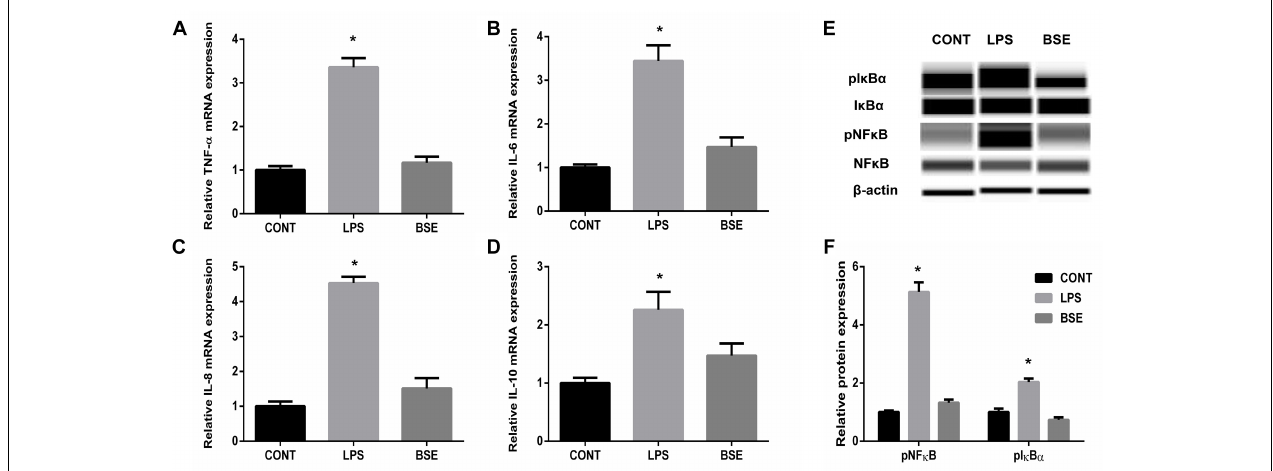
FIGURE 2 | Effects of Blidingia sp. extract on expression of inflammatory cytokines and expression of proteins involved in NF κ B pathway in ileum of lipopolysaccharide -challenged mice. (A) TNF- α mRNA expression; (B) IL-6 mRNA expression; (C) IL-8 mRNA expression; (D) IL-10 mRNA expression; (E) Western blotting results; (F) Relative abundance of pNF κ B and pI κ B α to total NF κ B and I κ B α protein expression, respectively. CONT, mice gavaged with sterile saline; LPS, mice injected with lipopolysaccharide; and BSE, mice gavaged with Blidingia sp. extract and injected with lipopolysaccharide. Values are expressed as mean ± SEM, n = 8 for qRT-PCR and n = 3 for Western blotting; ∗ p < 0.05.